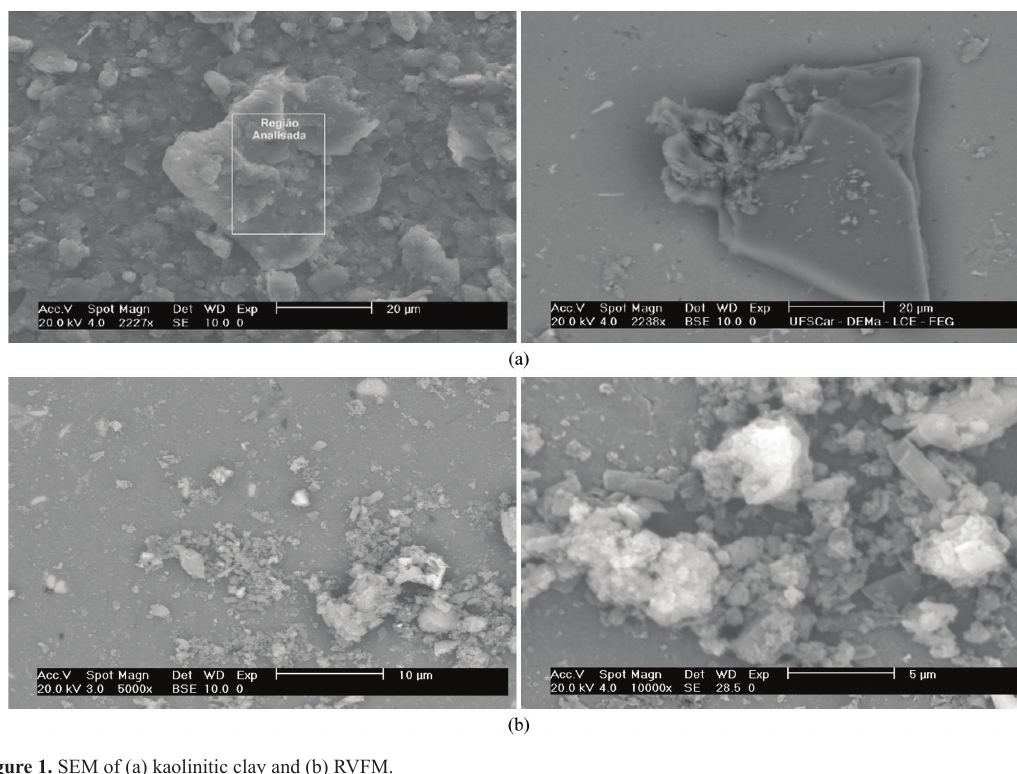
Figure 1. SEM of (a) kaolinitic clay and (b) RVFM.